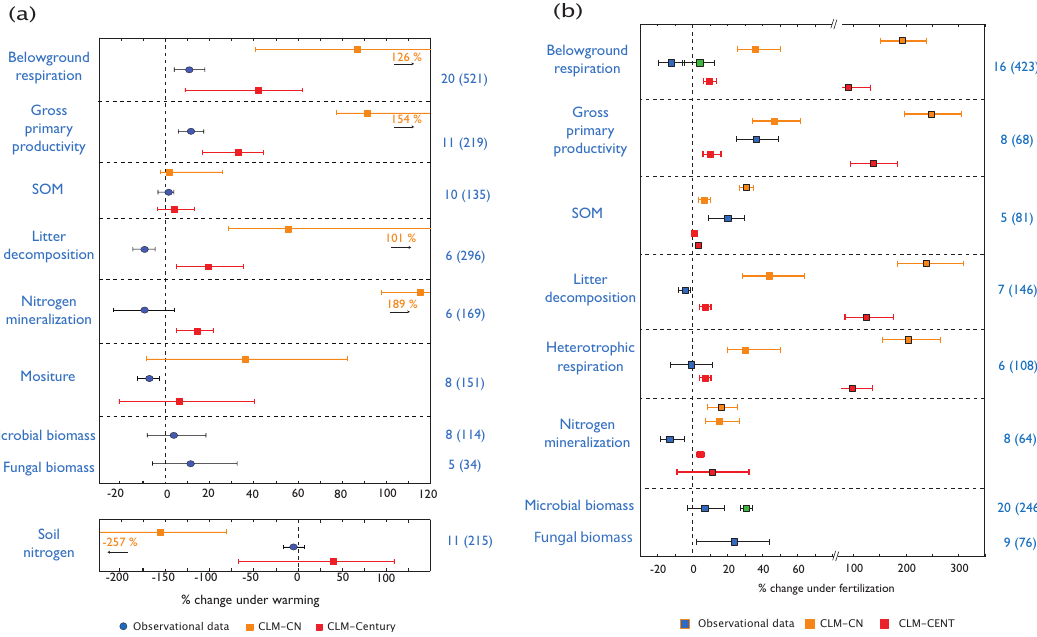
Figure 2. Response ratio of select variables under (a) warming and (b) nitrogen addition. The figures show the average response to perturba- tion derived from the observations (blue circles or squares), CLM-CN (orange squares), and CLM-Century (red squares). Also shown is the variance either side of the average. Under circumstances where the variance could not fit on the axis, a numerical value indicates the limits of variance. In Fig. 2b, R B is given as the response to the average nitrogen concentration and also to lower, more realistic concentrations (represented by the green square). The modeled response in Fig. 2b is the collated response following the addition of low nitrogen concen- trations (i.e., 0.2, 1.0, 2.0 and 3.0kg-Nha − 1 yr − 1 ) and high concentrations (20, 60 and 100kg Nha − 1 yr − 1 ). Note the axis change in Fig. 2b following the break. The number of individual studies and data points (in brackets) used in calculating the observation response ratio are given in blue on the right-hand side of the figure.